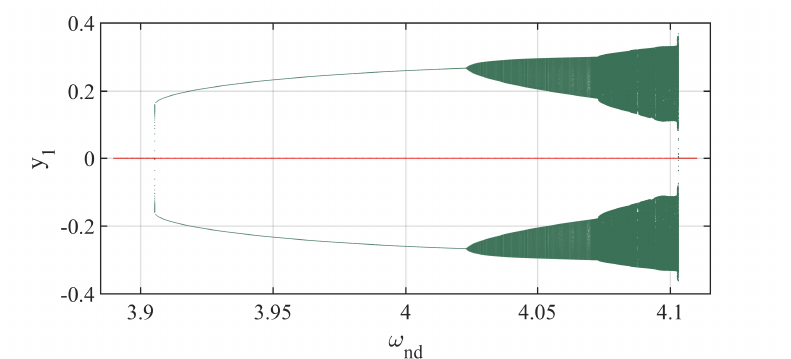
Figure 10. Co-existing attractors in the bifurcation diagram of y 1 : The x -axis is the non-dimensional parameter ω nd and the y -axis is the sampled value of y 1 . The parameters are: ζ 1 = 0.0868, ζ 2 = 0.1036, t 1 = 0.2413, t 2 = 0.288, b 1 = 45.7143, b 2 = 54.5737, a 1 = 5.8548 × 10 − 3 , D 1 = 1.5, β = 11.11, µ = 1.1938, δ 1 = 1. (Color